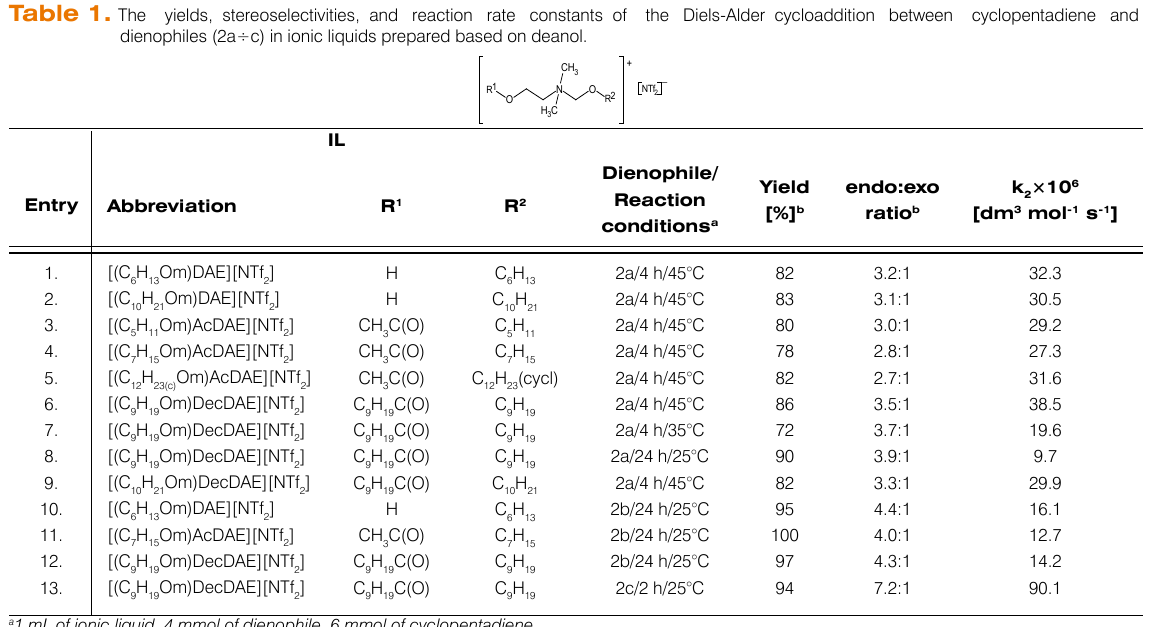
Table 2. Comparison of yield and stereoselectivity of the Diels-Alder reaction between cyclopentadiene and 2a in the presence of Y(OTf) deanol based ILs a . Entry IL b